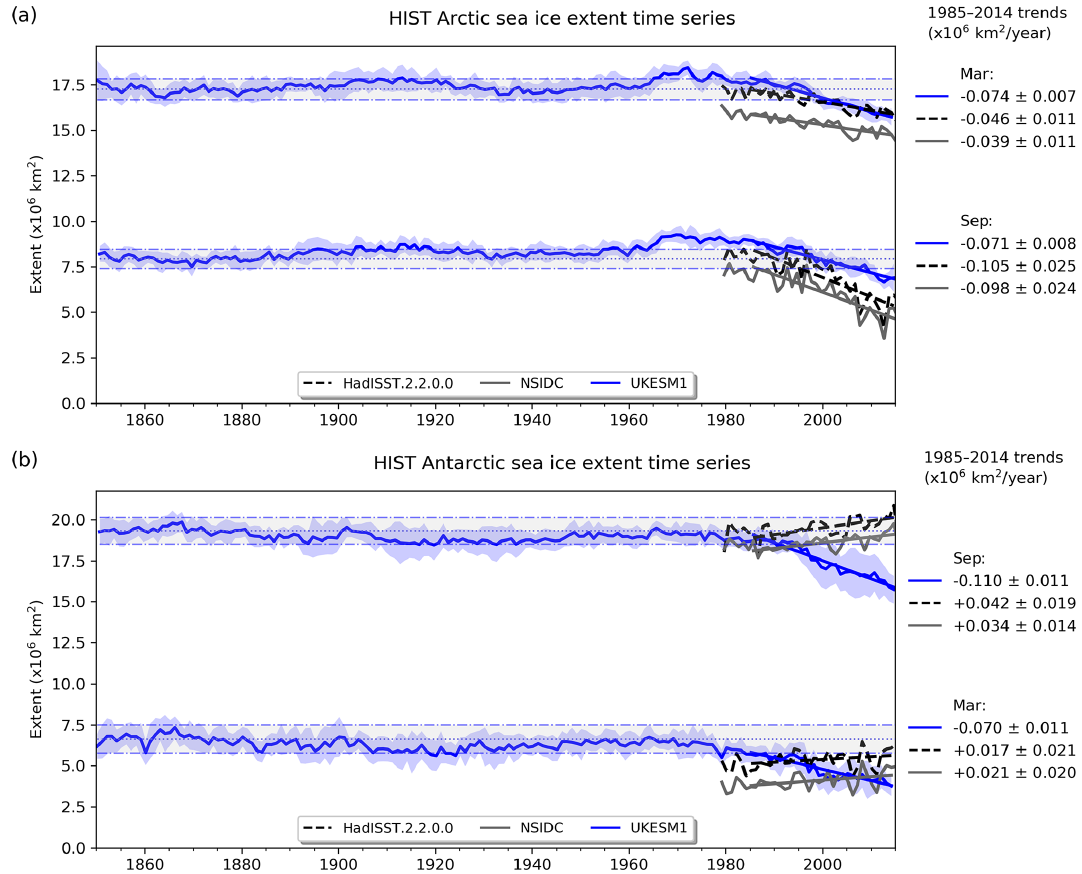
Figure 3. Observational (black, HadISST; grey, NSIDC) and simulated (blue) sea ice extent in the Arctic (a) and Antarctic (b) across the historical period (1850–2014), with recent (1985–2014) trends shown. Panels show extent for September and March, which roughly correspond to the seasonal minima and maxima. The model ensemble mean is shown, with ± 1 SD shaded in blue to show their